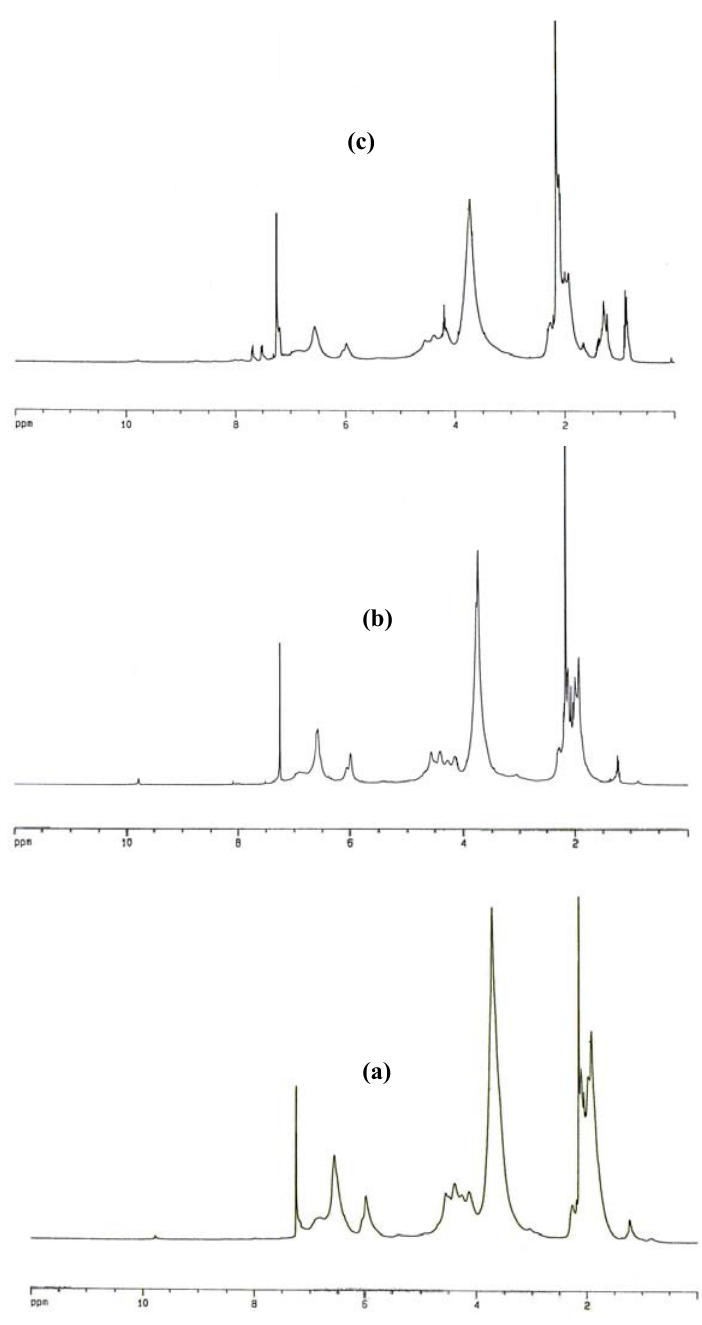
Figure1. 1 H-NMR spectra of unirradiated BCMP lignin (a) and irradiated lignins for 4h (b) and 120h